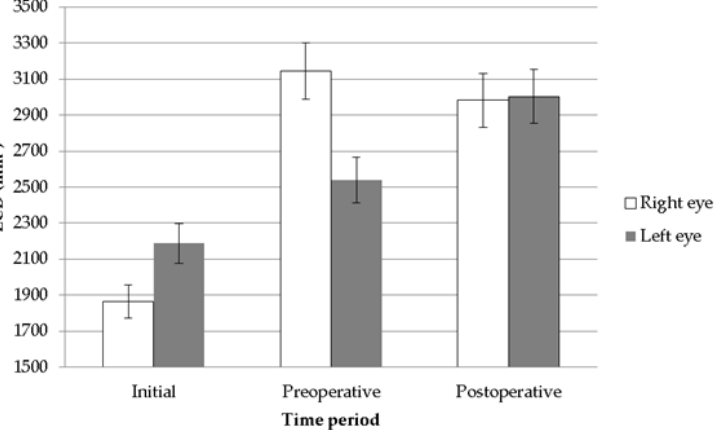
Figure 4. The endothelial cell morphology three months postoperatively with nominal magnification of 400×. ( A ) The endothelial morphology of right eye. ( B ) The endothelial morphology of left eye.